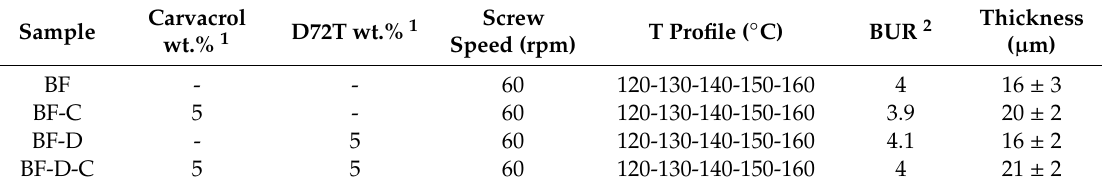
Table 1. Formulation, operating parameters used, and characteristics of the films